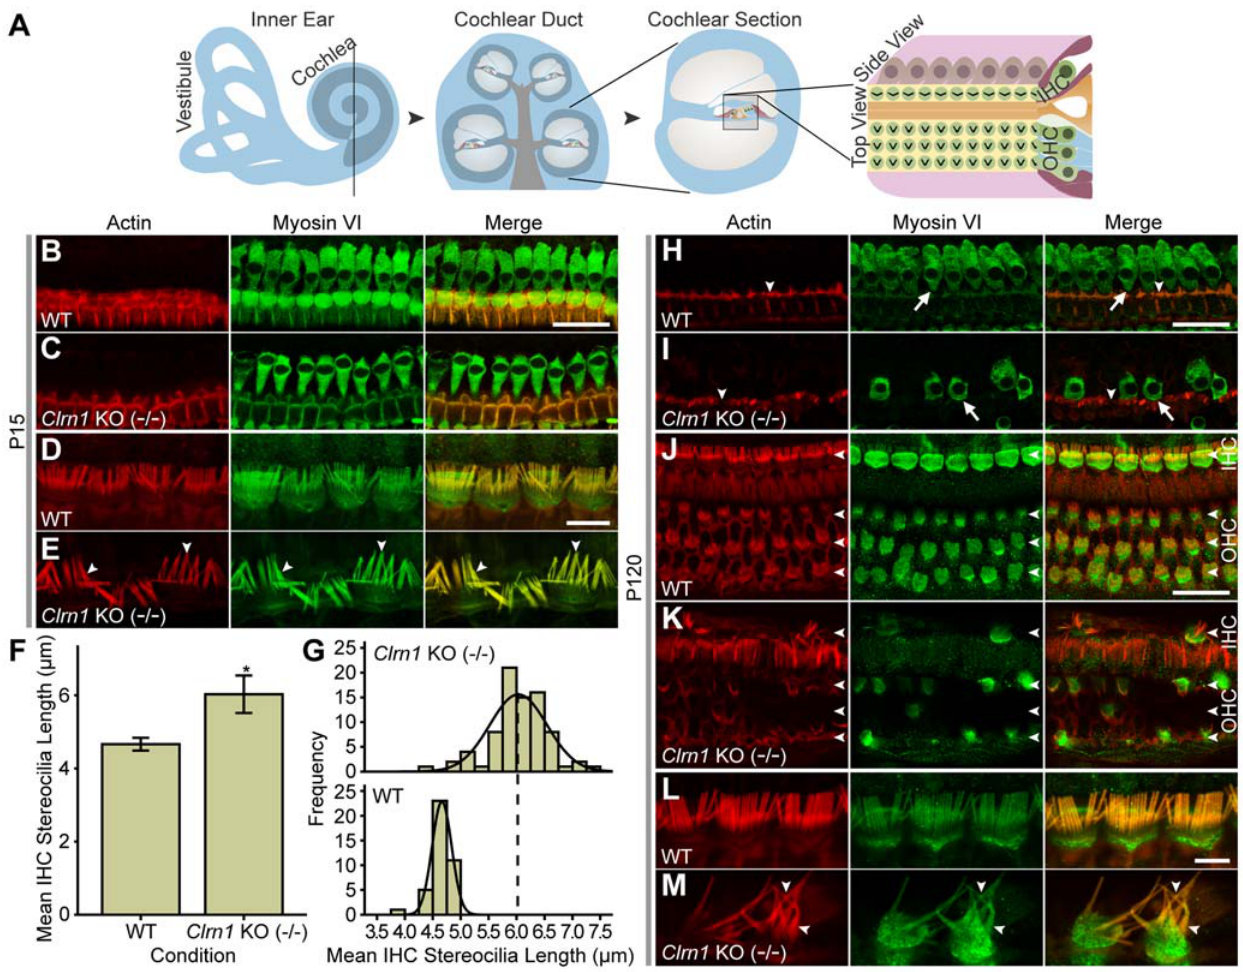
Figure 8. Cochlear hair cells of Clrn1 KO ( 2 / 2 ) mice degenerate with age and exhibit longer stereocilia. (A) Illustration of the inner ear, demonstrating the cochlea and auditory sensory epithelium. (B–E) Immunofluorescent confocal images of P15 and mouse inner-ear epithelia harvested from the middle turn of the cochlea, shown in side view. Filamentous actin was detected with rhodamine-Phalloidin (red), and anti-myosin VI labeling is shown in green. (B,C) At P15, the auditory epithelium in Clrn1 KO ( 2 / 2 ) (C) mice appears morphologically similar to WT animals (B). (D) WT animals maintain organized stereocilia on inner hair cells (IHCs). (E) Subtle IHC stereociliar abnormalities such as increased bundling and lengthening (arrowheads) are evident in KO animals at P15. (F,G) Quantitative analysis of IHC bundle lengths reveal considerably longer stereocilia (F) in P15 Clrn1 KO animals, distributed over a broader range of lengths (G, upper graph; n=80), which is distinguishable from the highly uniform lengths of WT stereocilia (G, lower graph; n=40). (H,I) Shown from the side view at P120, and compared to WT labeling (H), staining of Clrn1 KO auditory epithelia (I) indicates extensive degeneration and loss of IHCs. At this age, a disruption of supporting cell apical surfaces is apparent (I, arrowheads), and the surviving IHCs in the auditory epithelia of Clrn1 KO mice exhibit shortened hair cell bodies (I, arrows). (J,K) From a top view, a clear disruption and loss of both IHCs and OHCs is evident in the Clrn1 KO mutant (K, arrowheads). (L,M) IHCs from WT cochleas (L) possess highly ordered and symmetrical stereocilia, while Clrn1 KO IHCs (M) exhibit profoundly disorganized bundles of elongated and possibly fused stereocilia (arrowheads). *=P , 0.001. Error bars=1 SD. Scale bars: In B (25 m m) applies to B and C; in D (7.5 m m) applies to D and E, in H (25 m m) applies to H and I, in J (20 m m) applies to J and K, in L (5 m m) applies to L and